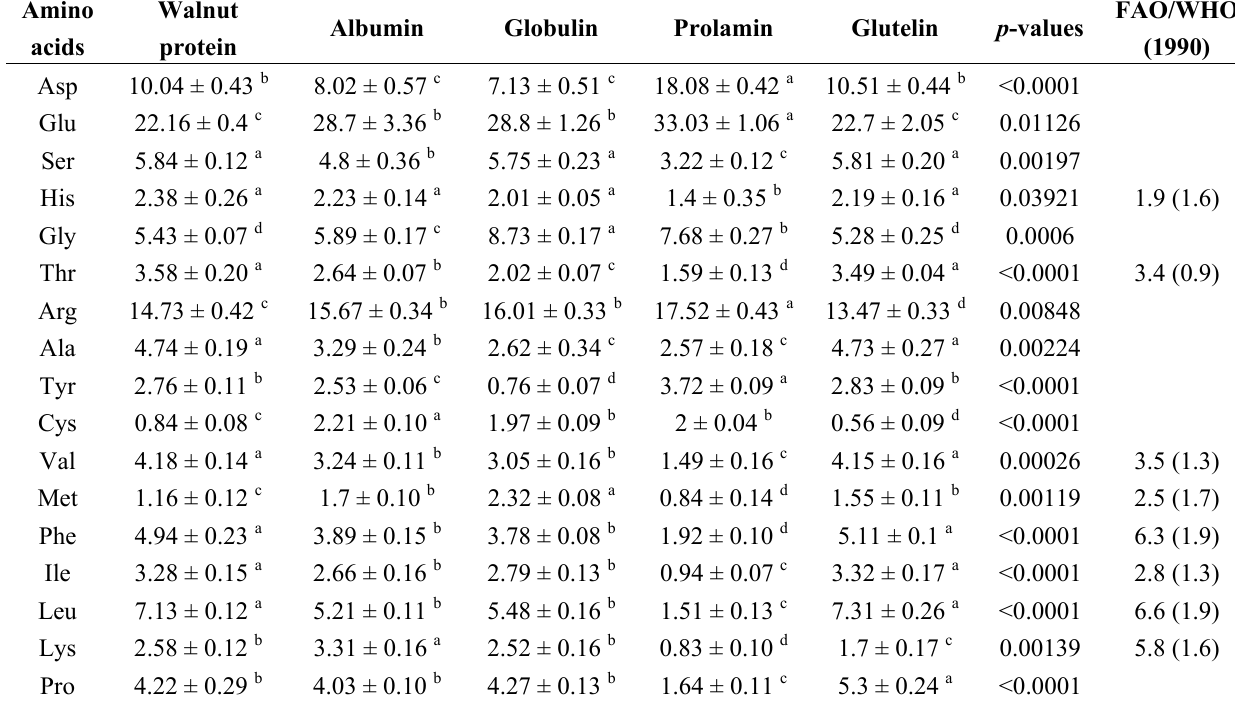
Table 2. Amino acid composition of walnut proteins and protein